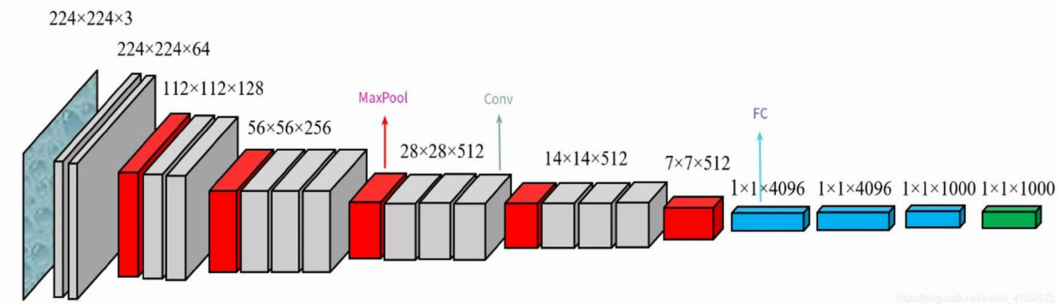
Figure 4. Schematic diagram of the VGGNet model architecture.